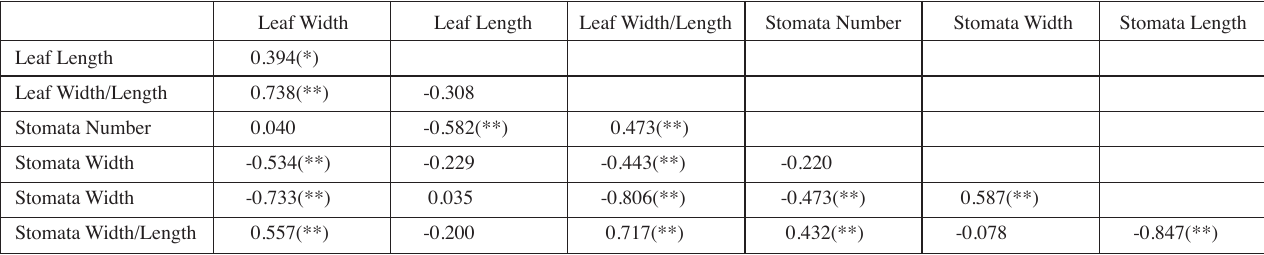
Tab. 3: Correlations amongst the leaf and stomata